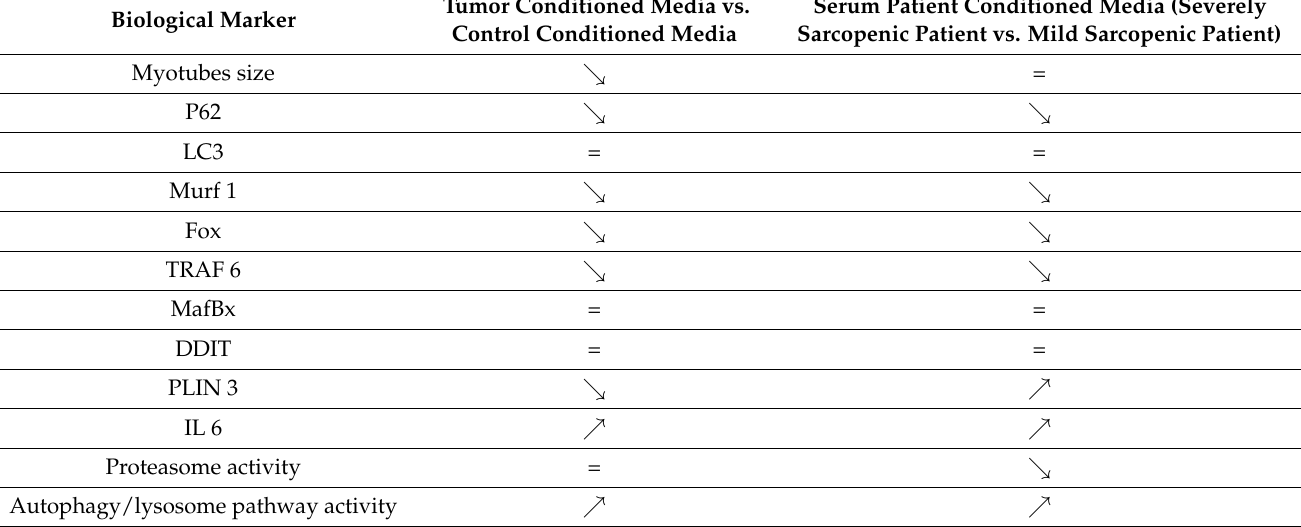
Table 4. Comparison of the effect of tumor-conditioned media and patient’s serum on human myotubes. Tumor Conditioned Media vs. Serum Patient Conditioned Media (Severely Biological Marker Control Conditioned Media Sarcopenic Patient vs. Mild Sarcopenic